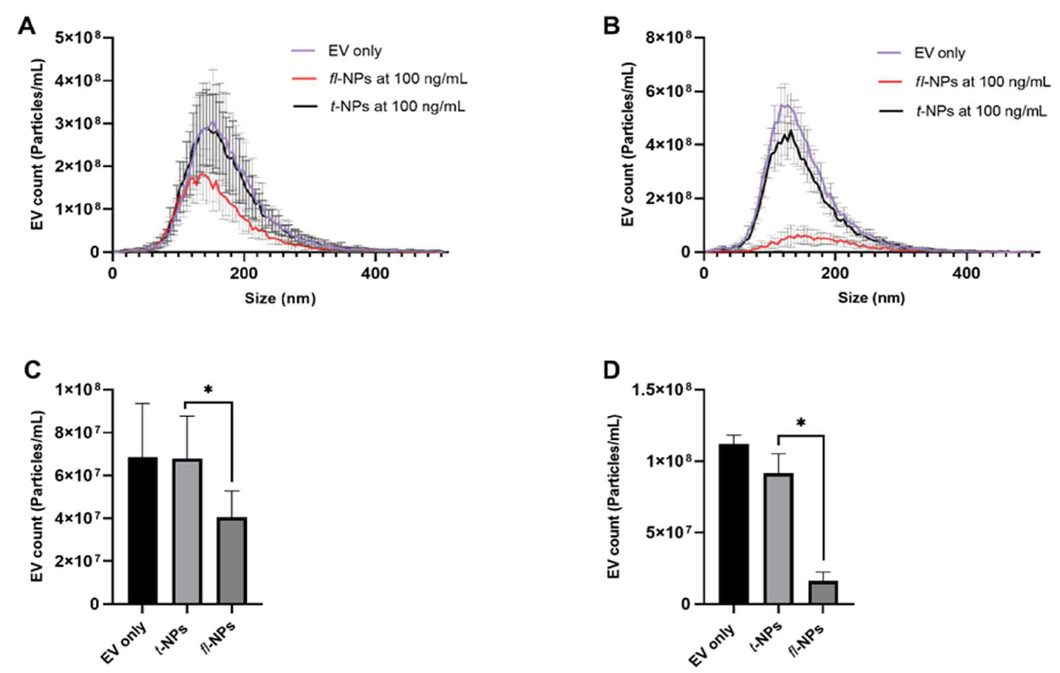
Figure 11. The size distribution and concentration of fluorescent and total NPs for BFF and seminal plasma-derived EVs purified with SEC columns. EVs were labeled with 100 ng/mL of CMG and fl- NPs were measured at a minimum brightness threshold value of 25. Size distribution ( A , B ), and particle concentration ( C , D ) of BFF and seminal plasma-derived EVs incubated at 25 °C respectively. The concentration of fl- NPs of BFF and seminal plasma-derived EVs were significantly different ( p ≤ 0.05) than the corresponding t-NPs of BFF and seminal plasma-derived EVs. Thus, were marked with an asterisk (*) symbol. EV only controls, fl- , and t-NPs of BFF and seminal plasma-derived EVs were measured at fluorescent and scatter mode of NTA. EVs were diluted in 1 × PBS, and the particle concentration measurement was done at a neutral pH of 7.2 (mean ± SD, n = 9).